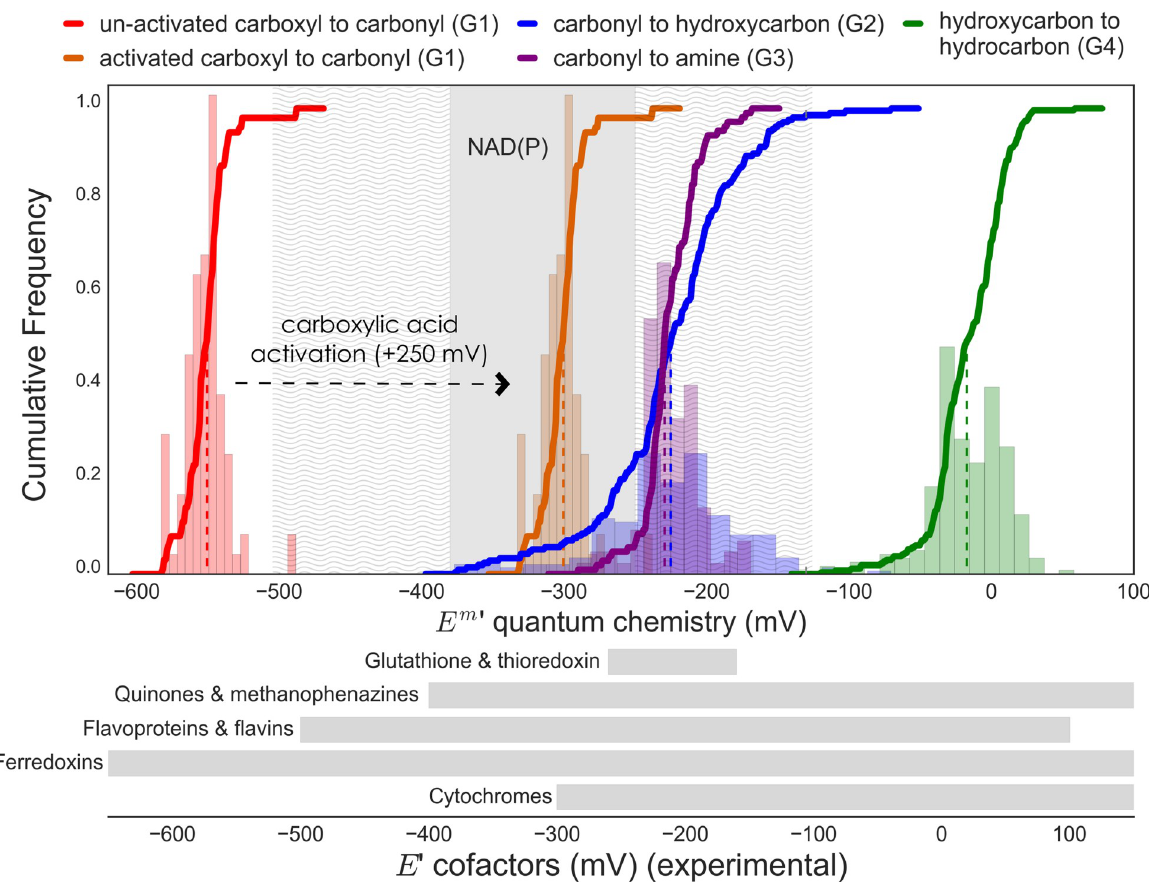
Fig 3. Distributions of predicted standard transformed redox potentials at pH = 7 and I = 0.25 for a dataset of 650 natural and non-natural reactions. The average reduction potentials for each reaction category are (values rounded to nearest multiple of 5): un-activated carboxylic acid to carbonyl (G1: < E 0 m > = − 550 mV ), activated carboxylic acid to carbonyl (activated G1: < E 0 m > = − 300 mV ), carbonyl to hydroxycarbon (G2: < E 0 m > = − 225 mV ), carbonyl to amine (G3: < E 0 m > = − 225 mV ), and hydroxycarbon to hydrocarbon (G4: < E 0 m > = − 15 mV ) Both histograms and cumulative distributions (bold lines, right y-axis) are shown. The distributions for unactivated and activated carboxylic acid to carbonyl reductions (red and purple) are the same, but shifted by +250 mV. Dashed colored lines show the median redox potential for each reaction category. Grey shaded regions corresponds to the range of NAD(P) redox potential, while light grey wavy lines delimit the region of reversible oxidation/reduction by NAD(P)/NAD(P)H. Ranges of reduction potentials for different alternative cofactors are shown as grey rectangles underneath graph (S1